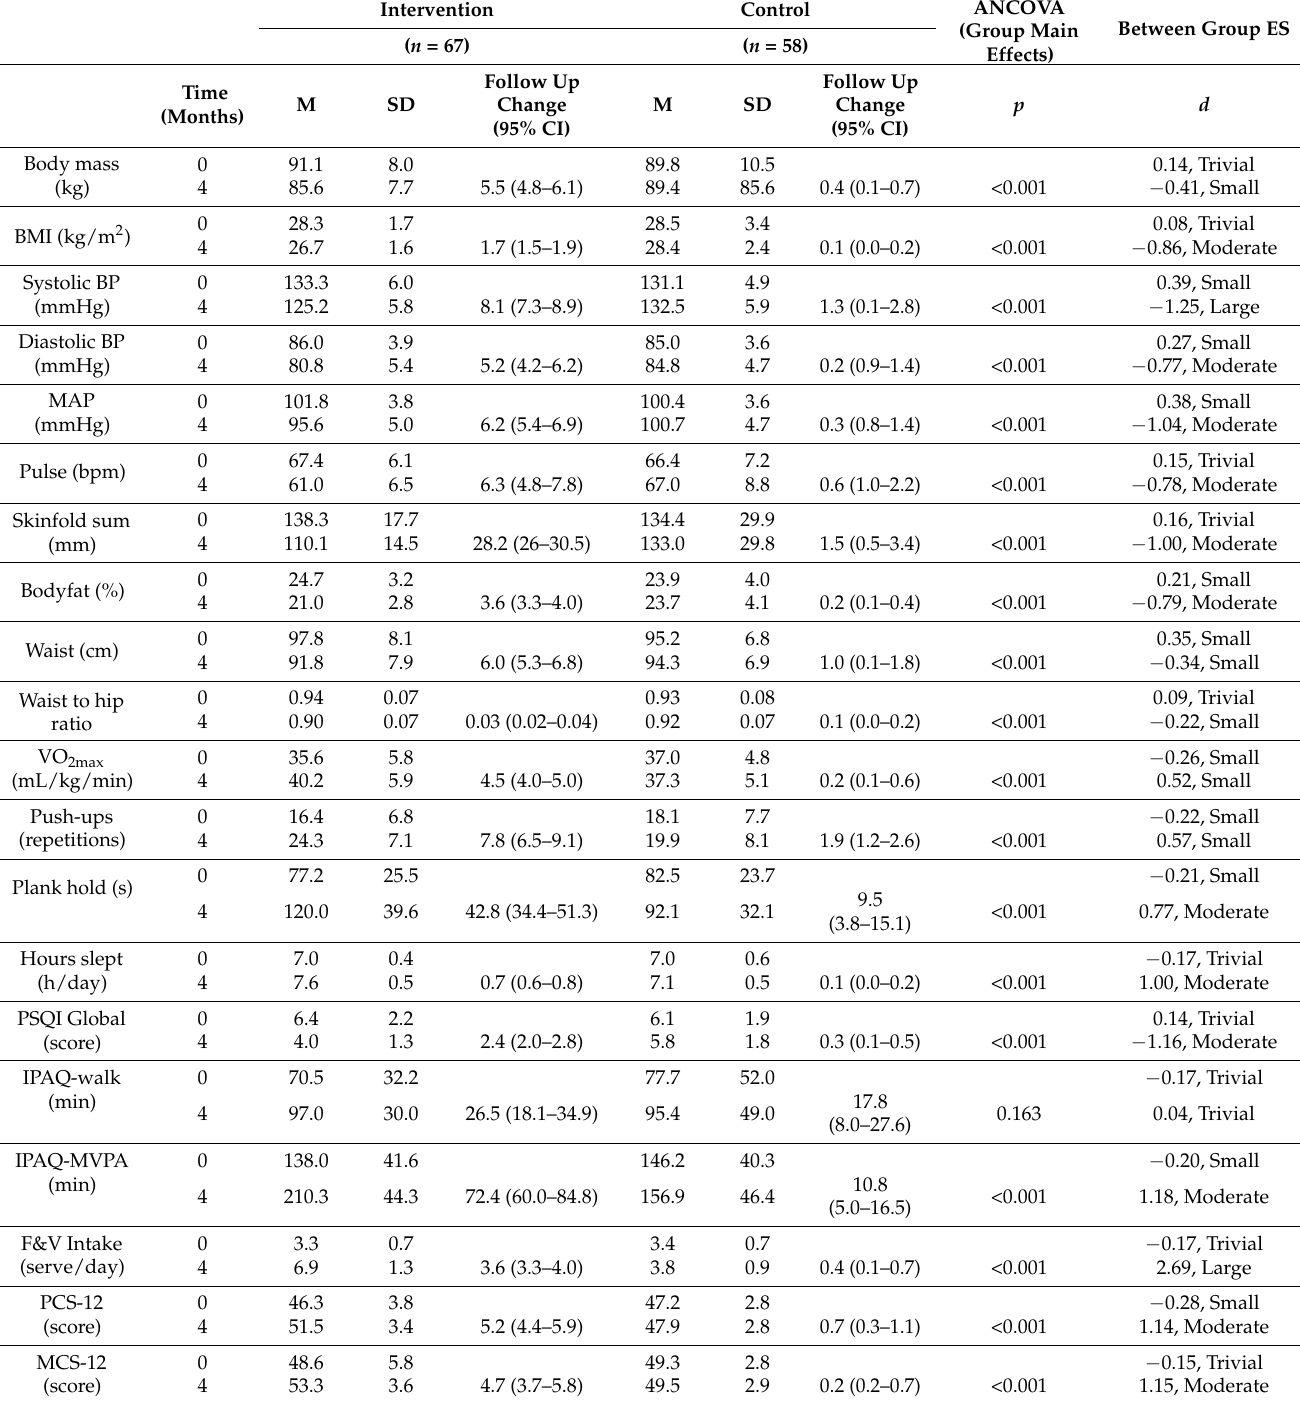
Table 2. Changes in objective and self-report health measures from baseline to post-intervention at 4-months. Intervention Control ANCOVA ( n =